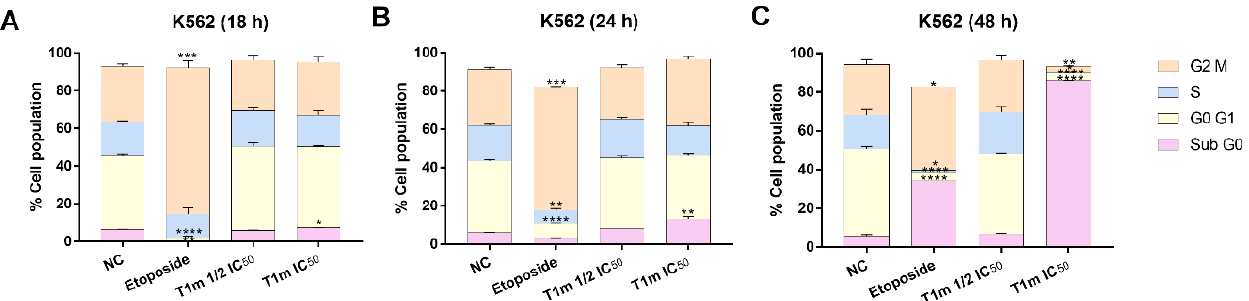
Figure 2. T1m induces increases in the sub-G0 cell population without causing cell cycle arrest. Effects of T1m concentration on cell cycle status in K562 cells at three different T1m exposure times: 18 h ( A ), 24 h ( B ), and 48 h ( C ). Data are expressed as the percentage of cell populations and represent mean ± SEM of three independent experiments of cell cycle phase distribution. A significant difference between cell cycle phases was identified using a one-way analysis of variance (ANOVA) followed by a Dunnett’s post -hoc test. Significance was set at * p < 0.05, ** p < 0.01, *** p < 0.001, and **** p < 0.0001 vs. negative control (NC).